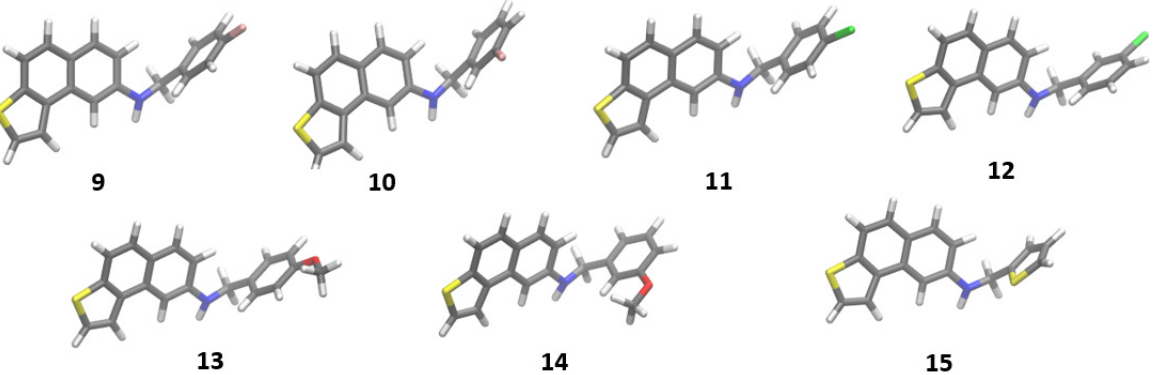
Figure 10. The most stable conformers of trans -isomers of naphtho-thiophene benzylamines 9 – 15 , optimized at the M06-2X/6-31g(d) level of theory.